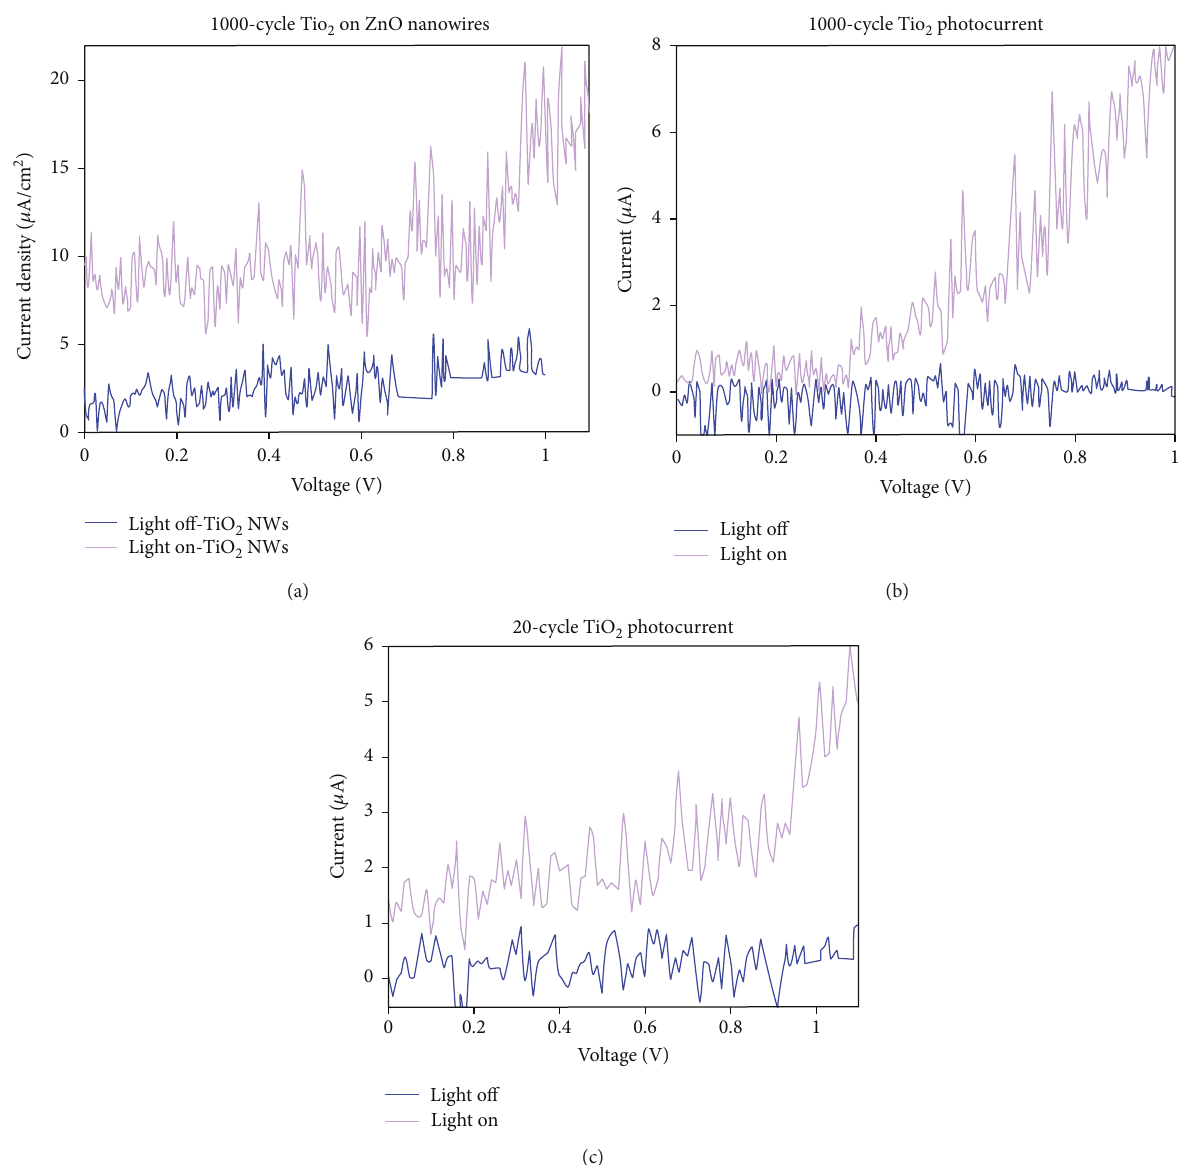
Figure 8: Linear sweep voltammetry under lit and dark conditions. (a) High-aspect ratio TiO photocurrent ( ~ 1 order of magnitude over planar TiO ranging from ~ 0 to 8 μ A. (c) Planar 20 cycle TiO